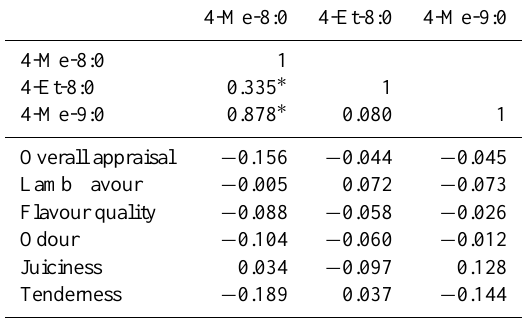
Table 2. Correlation coefficients of concentrations of the fatty acids 4-Me-8:0, 4-Et-8:0 and 4-Me-9:0 (ngmg − 1 ) in sheep subcutaneous adipose tissue and six sensory traits (Henseler et al.,